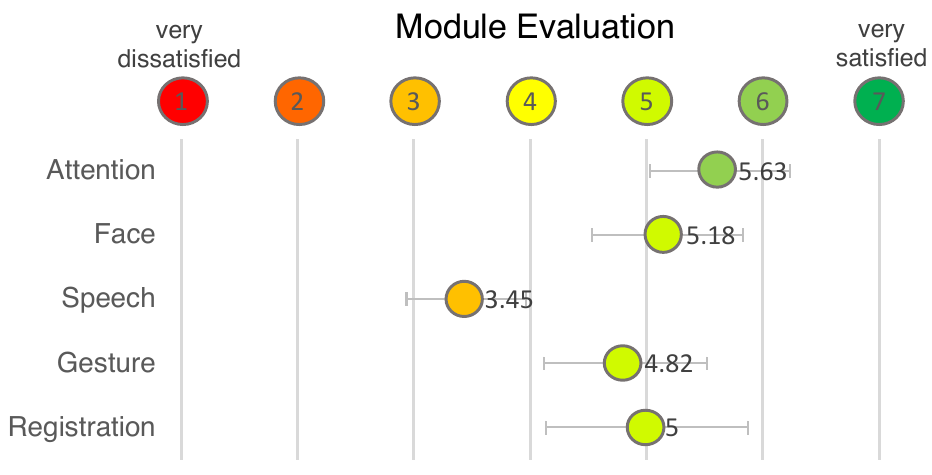
Figure 17. User rating of individual